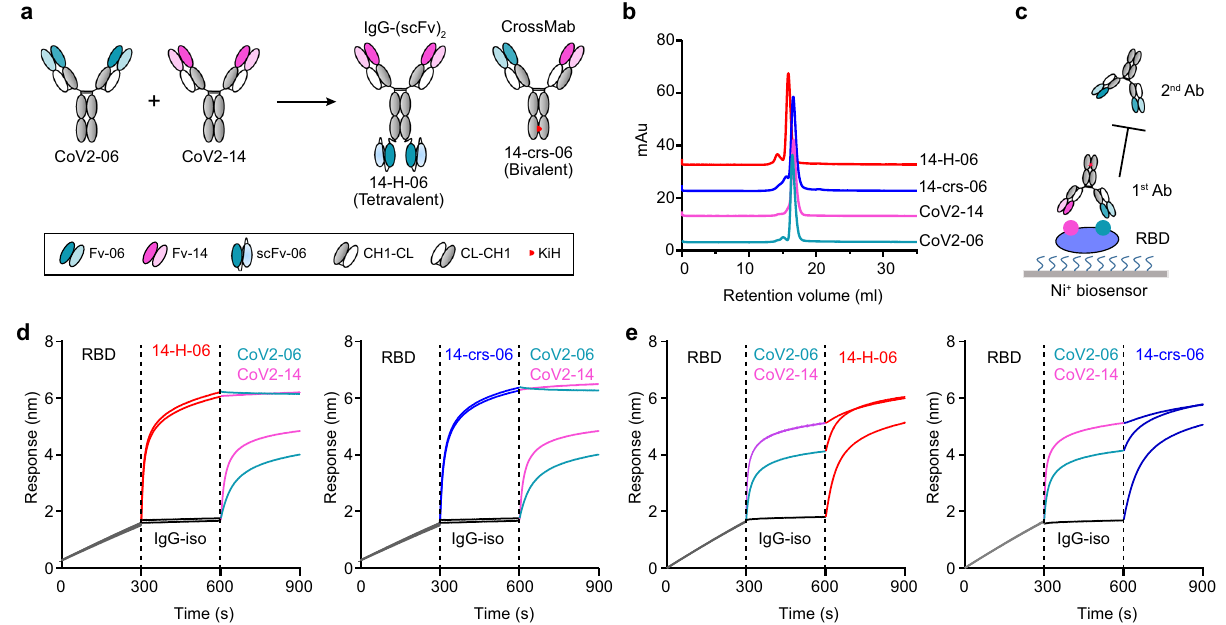
Fig. 1 | Engineering of bispeci fi c antibodies. a Schematic diagram of engineering bispeci fi c antibodies. A tetravalent bsAb (14-H-06) and a bivalent bsAb (14-crs-06) were engineered from two parental IgGs that bind to two distinct epitopes on the RBD. The modules for antibody engineering are illustrated in the box. Fv: variable fragment; scFv: single-chain Fv, constructed as VH-(G 4 S) 3 -VL; CH1-CL: constant region1forheavychain(CH1)and constantregionforlightchain(CL);CL-CH1:the crossover format of CH1-CL; KiH: the Knob-into-Hole design with the T366W (Knob) + S354C mutations in the heavy chain CH3 region on one arm and the T366S+L368A+Y407V (Hole)+ Y349C mutations in the CH3 region on the other arm. b Purities of indicated antibodies were analyzed by SEC. c The in-tandem BLI-